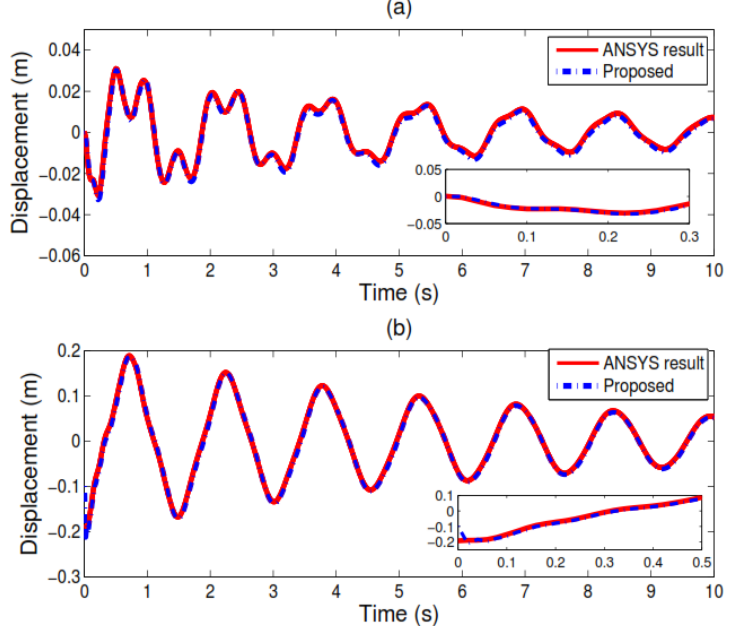
Figure 11. The response comparisons with ANSYS at nodes 28 and 50 in the x direction: ( a ) node 28 and ( b ) node 50.